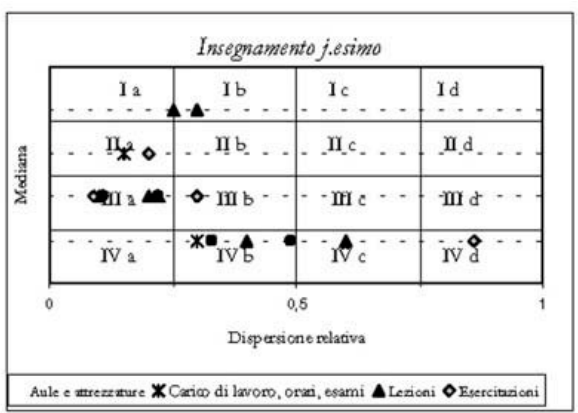
Figura 5b – Suddivisione dell’area del grafico in V = 16 sotto quadranti ( seconda ipotesi ). La variabili- tà ha un peso minore nella differenziazione qualitativa tra